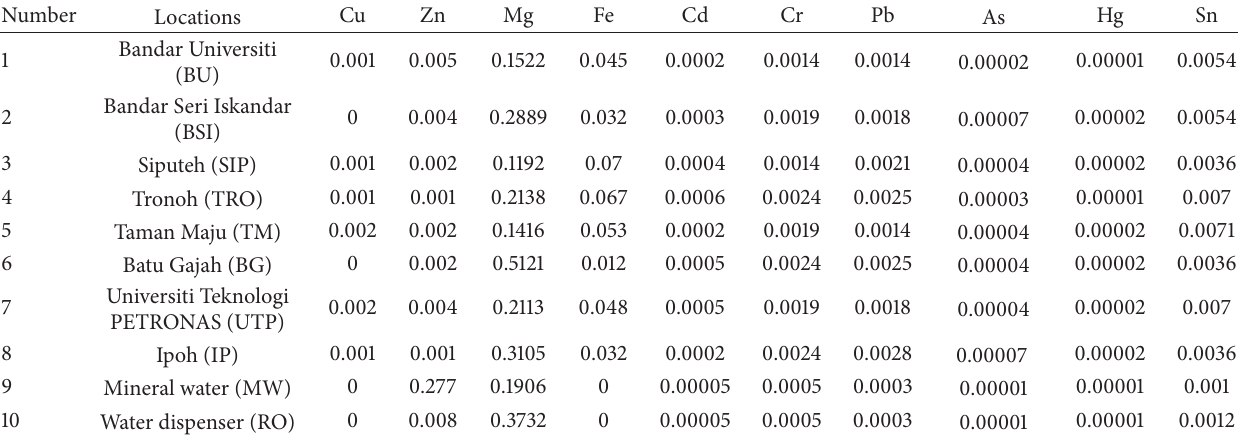
Table 4: Concentration of heavy metals (mg/L) in drinking water samples of Perak state,